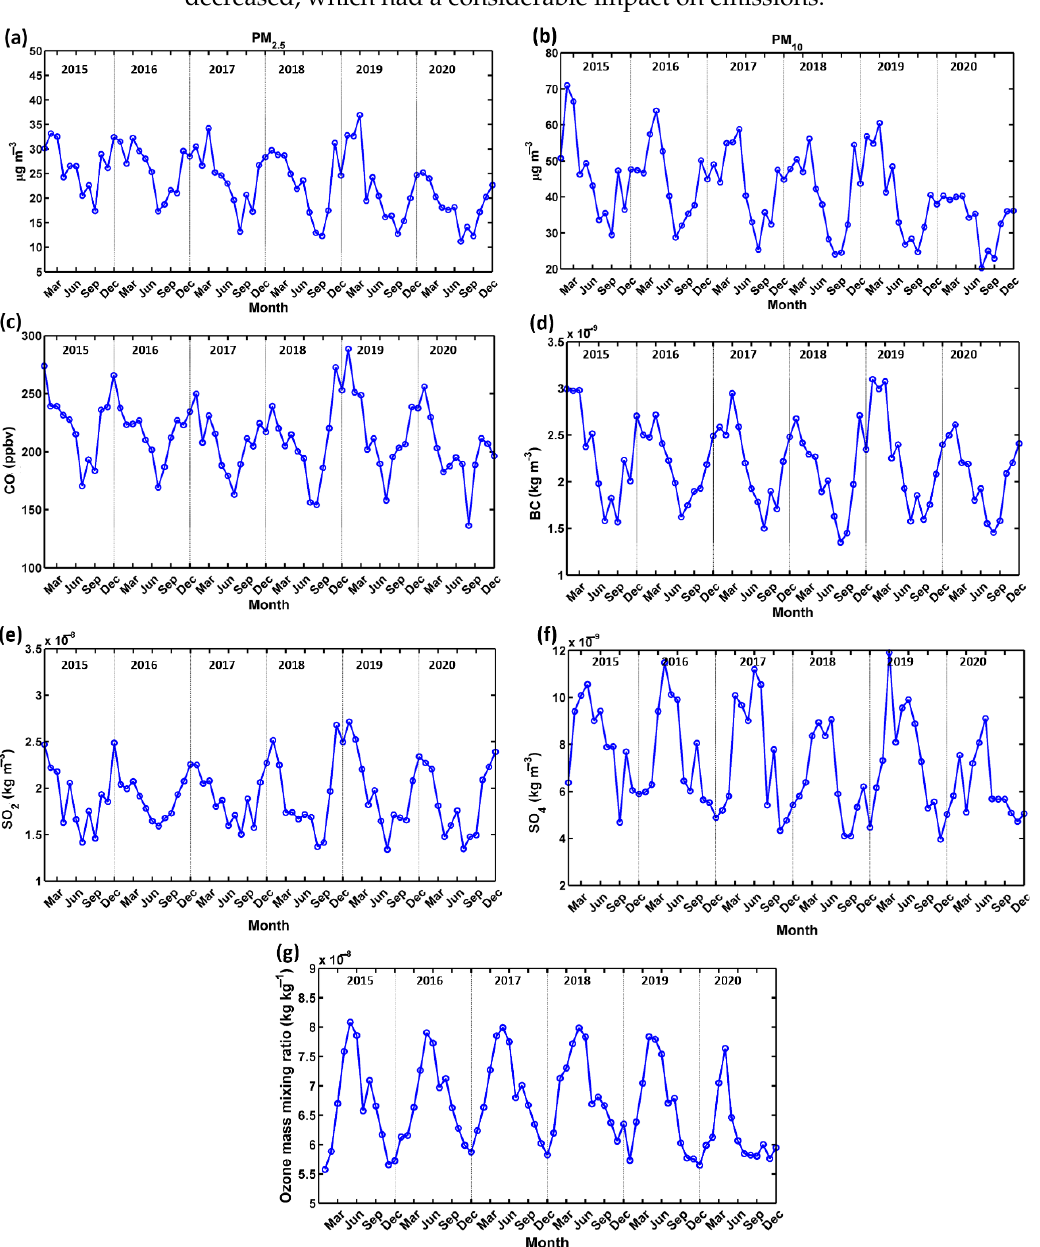
Figure 2. Monthly average concentrations of particulate matter (PM) and other pollutants over South Korea (2015–2020). ( a ) PM 2.5 , ( b ) PM 10 , ( c ) CO, ( d ) BC, ( e ) SO 2 , ( f ) SO 4 , and ( g ) ozone mass mixing ratio. The monthly mean variability across South Korea for CO, BC, SO 2 , SO 4 , and O 3 are shown in Figure 2c–g, respectively. The concentrations of CO, BC, and SO 2 were high